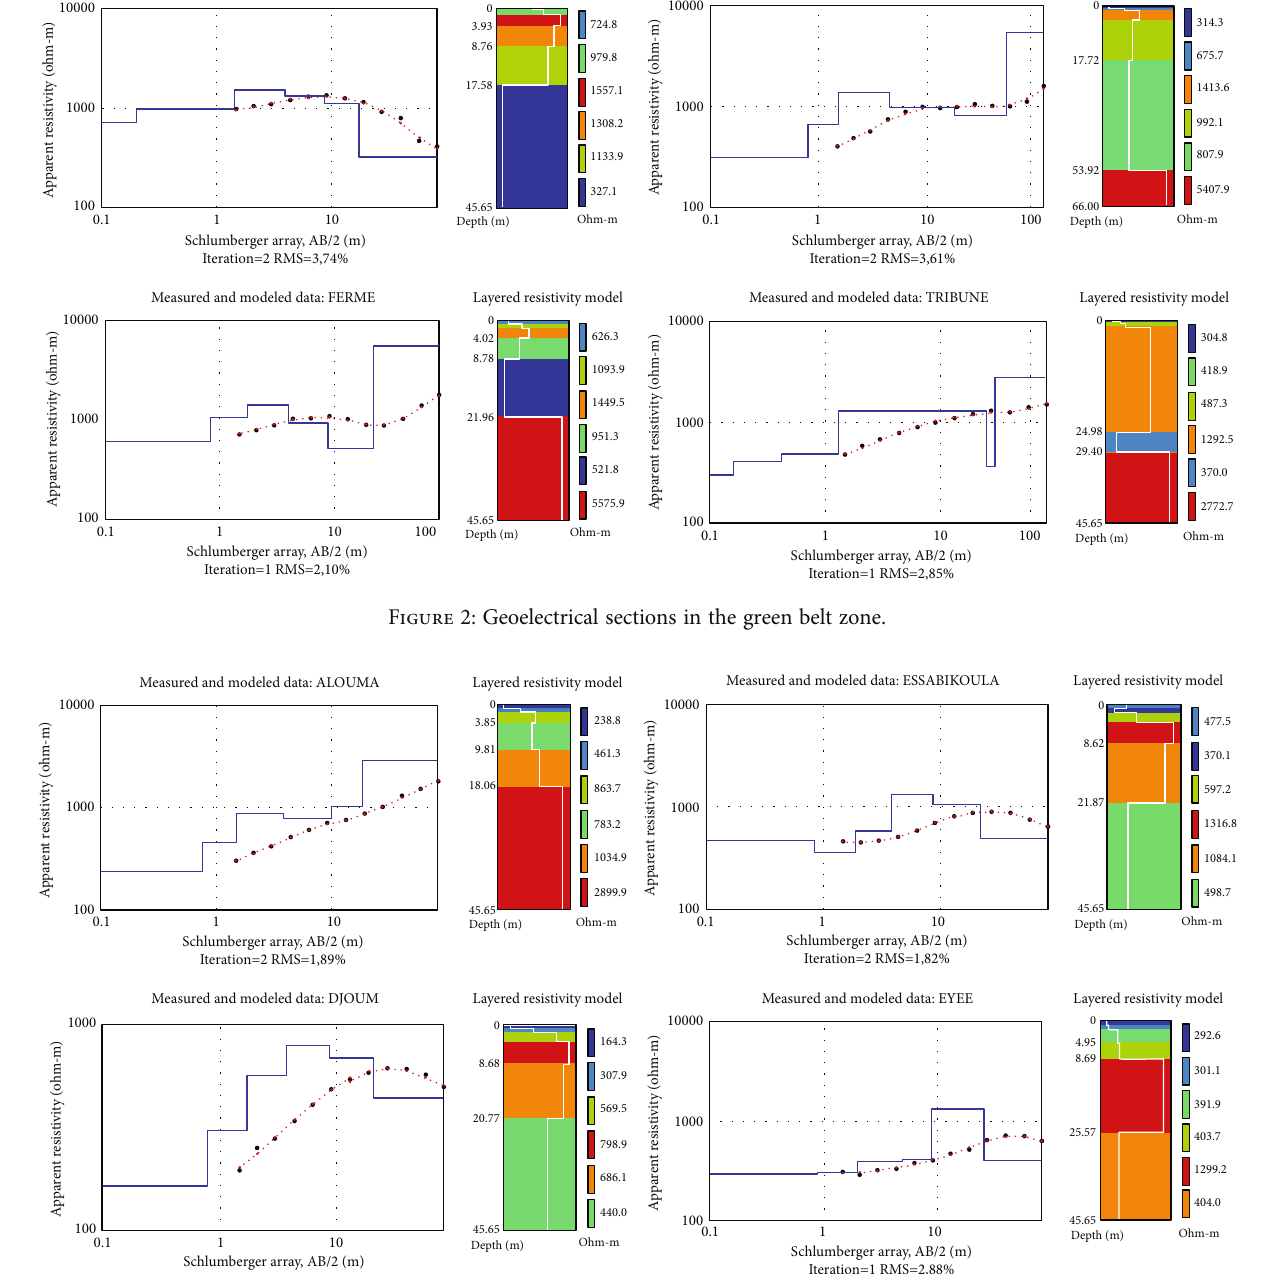
Figure 3: Geoelectrical sections in the plutonic area. (ii) Middle layer: in the plutonic zone, average values of 9.32m for thickness, 2.12-08cm/s for permeability, and 1302 Ω · m resistivity were obtained. The follow- ing average values were obtained in the green belt area: 4.35m thickness, 1.17-07cm/s for permeability, and 943 Ω · m resistivity (iii) Deep layer: in the plutonic zone, an average perme- ability of 4.86-09 cm/s with an average thickness of